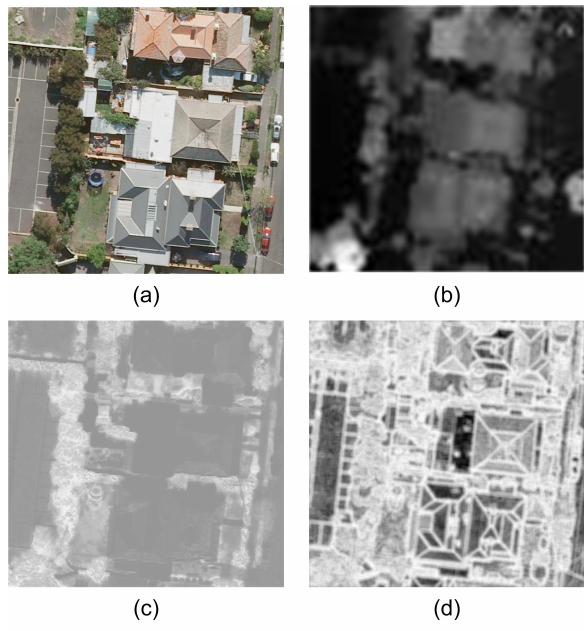
Figure 2: The test scene: (a) orthoimage, (b) LIDAR data shown as a grey-scale grid, (c) NDVI image from (a), and (d) entropy image from (a).